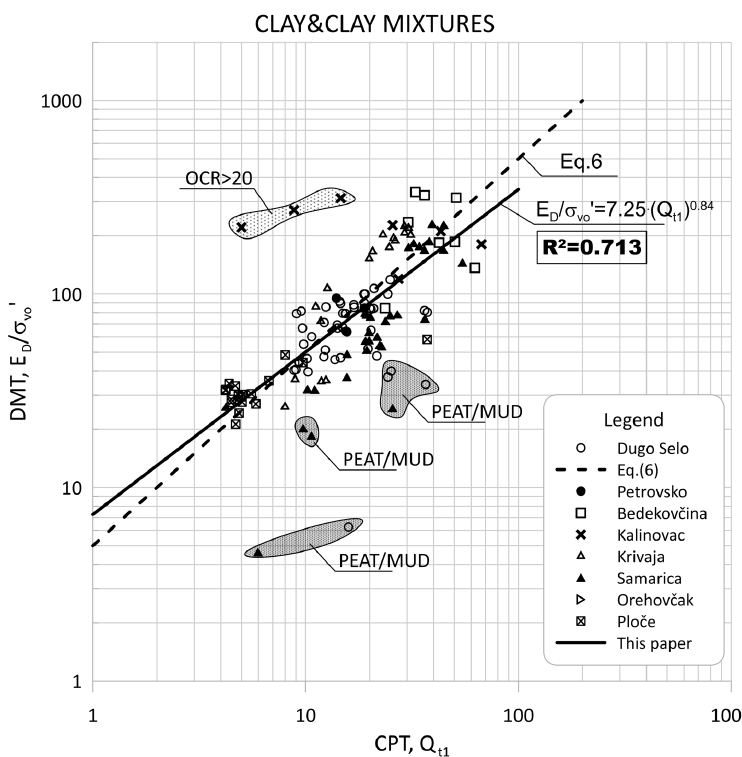
versus 𝑄𝑄 𝑡𝑡1 𝐸𝐸 𝐷𝐷 𝜎𝜎′ 𝑣𝑣0 ⁄